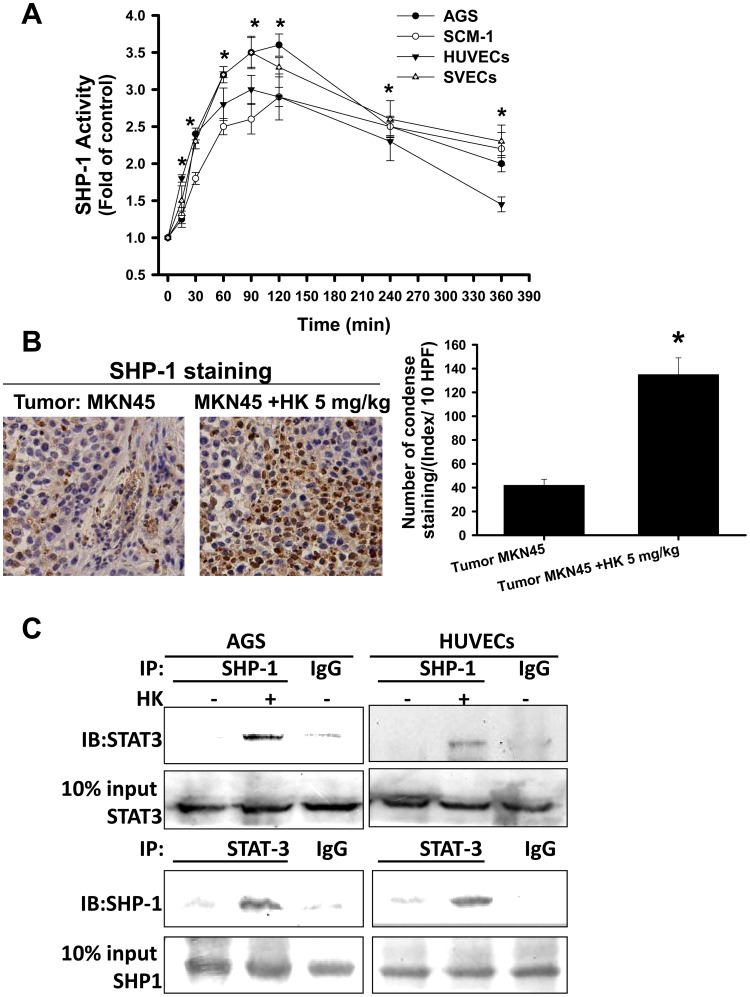
Honokiol enhanced the phosphatase SHP-1 activity and the interaction with STAT-3 in gastric cancer cells and endothelial cells and the SHP-1 protein expression in tumors.Cells were treated with honokiol (HK) for various time courses as indicated. (A) Cells were treated with honokiol (HUVECs, 20 µM; SVECs, 20 µM; AGS, 20 µM; SCM-1, 40 µM) at the indicated times, and then the SHP-1 activities were measured. Data are presented as mean±SEM (n = 7). *P<0.05 as compared with control. (B) Immunohistochemistry for SHP-1 expression in metastatic tumors isolated from mice with or without HK treatment is shown. The sections were stained with anti-SHP-1 antibody. (C) Interaction of STAT-3 and SHP-1 was detected in AGS cells or HUVECs. Immunoprecipitated proteins were collected and subjected to SDS-PAGE and immunoblotting with anti-STAT-3 or anti-SHP-1 antibodies. In A and B, data are presented as mean ± SEM (n = 5). *p<0.05 as compared with control. In C, the results shown are representative of at least four independent experiments.